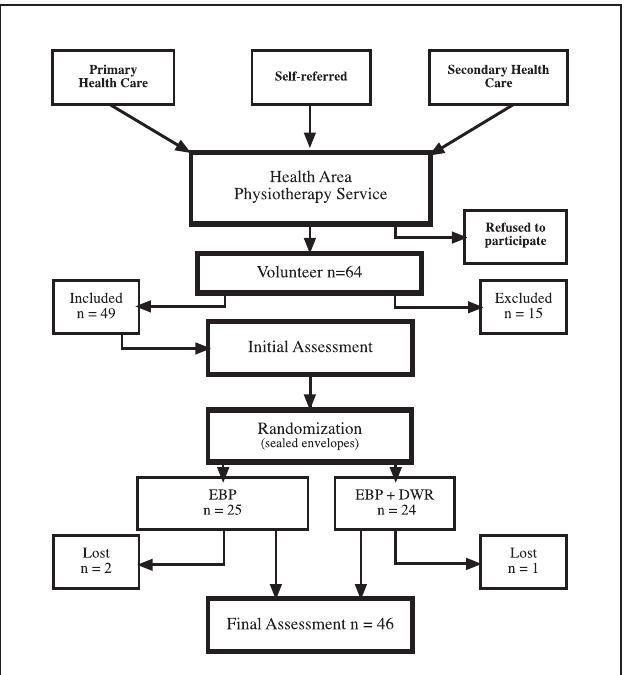
Figure 1. Recruitment algorithm.